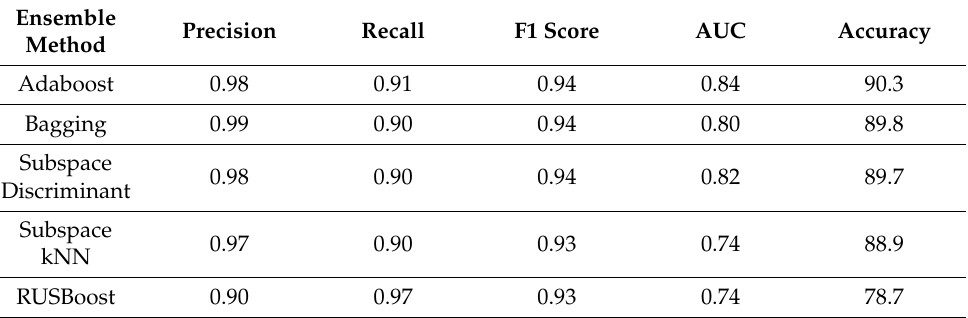
Table 5. Various validation parameters on five-fold CV.